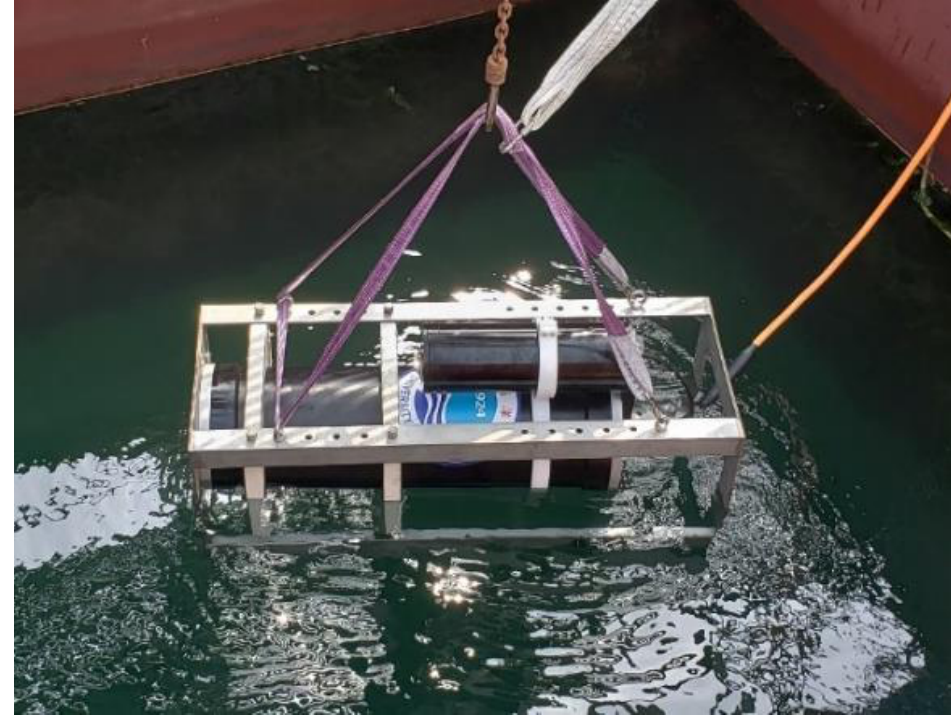
Figure 7. Photo of the field experiment.